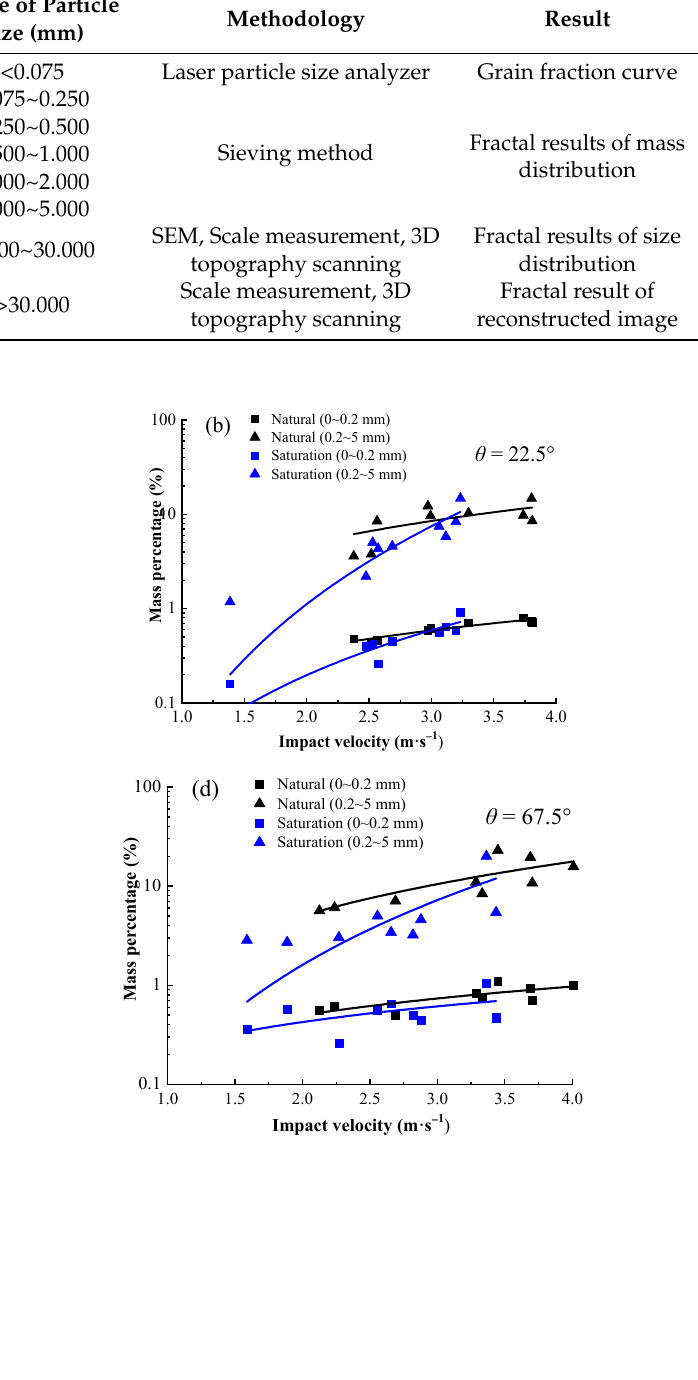
Table 2. Classification criteria and analysis method of rockburst debris.